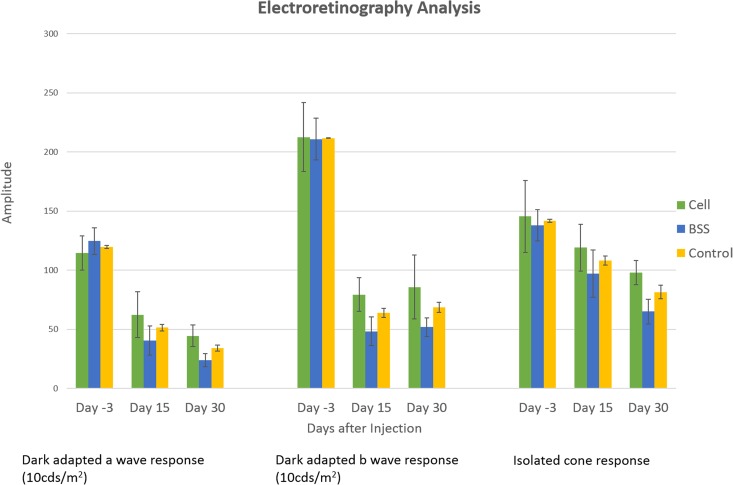
Retinal function.The dark adapted ERG a- and b-wave response amplitudes (10 cd.s/m2) and the isolated cone response at days -3, 15 and 30 for each experimental group. Although there was a trend that the ERG amplitude of the injected group was higher than that of the non-injected and control groups at days 15 and 30, the differences in ERG responses between the studied groups were not statistically significant at any time point post injection (p>0.05). All groups showed undetectable ERG at days 70. Error bars indicate standard error of the mean.